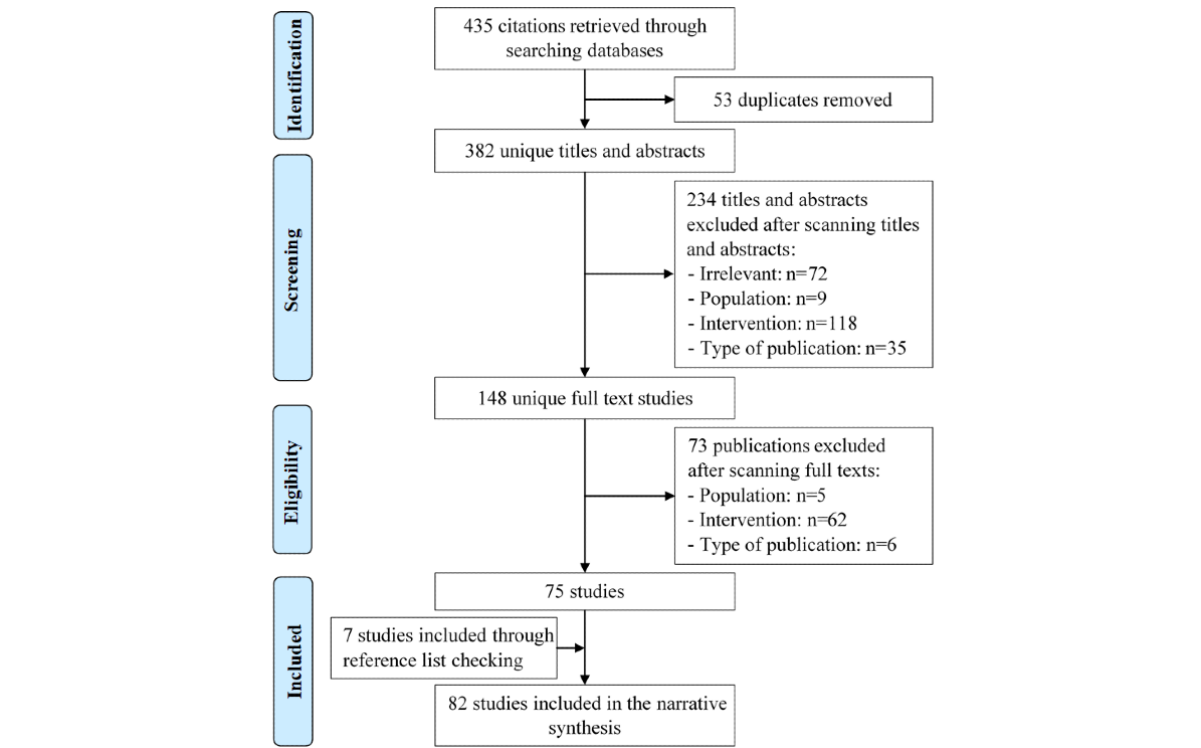
Figure 1. Flowchart of the study selection